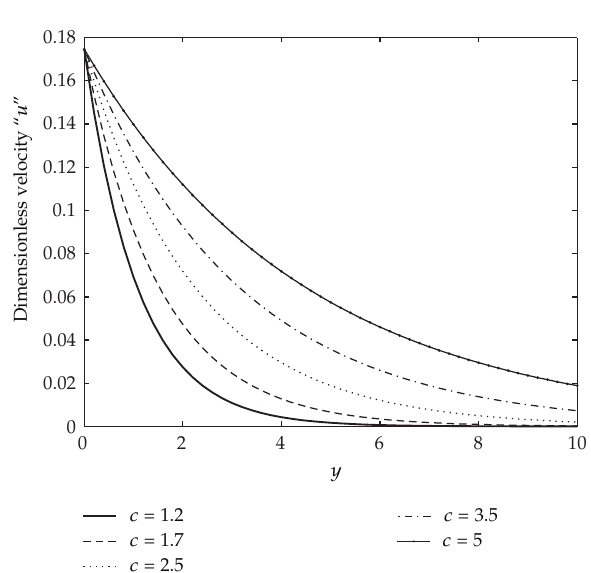
Figure 2: Backward wave-front type travelling wave solution (cid:3) 4.12 (cid:4) varying c when γ (cid:8) 0 . 6, β (cid:8) 4, and t (cid:8) π/ 2 are